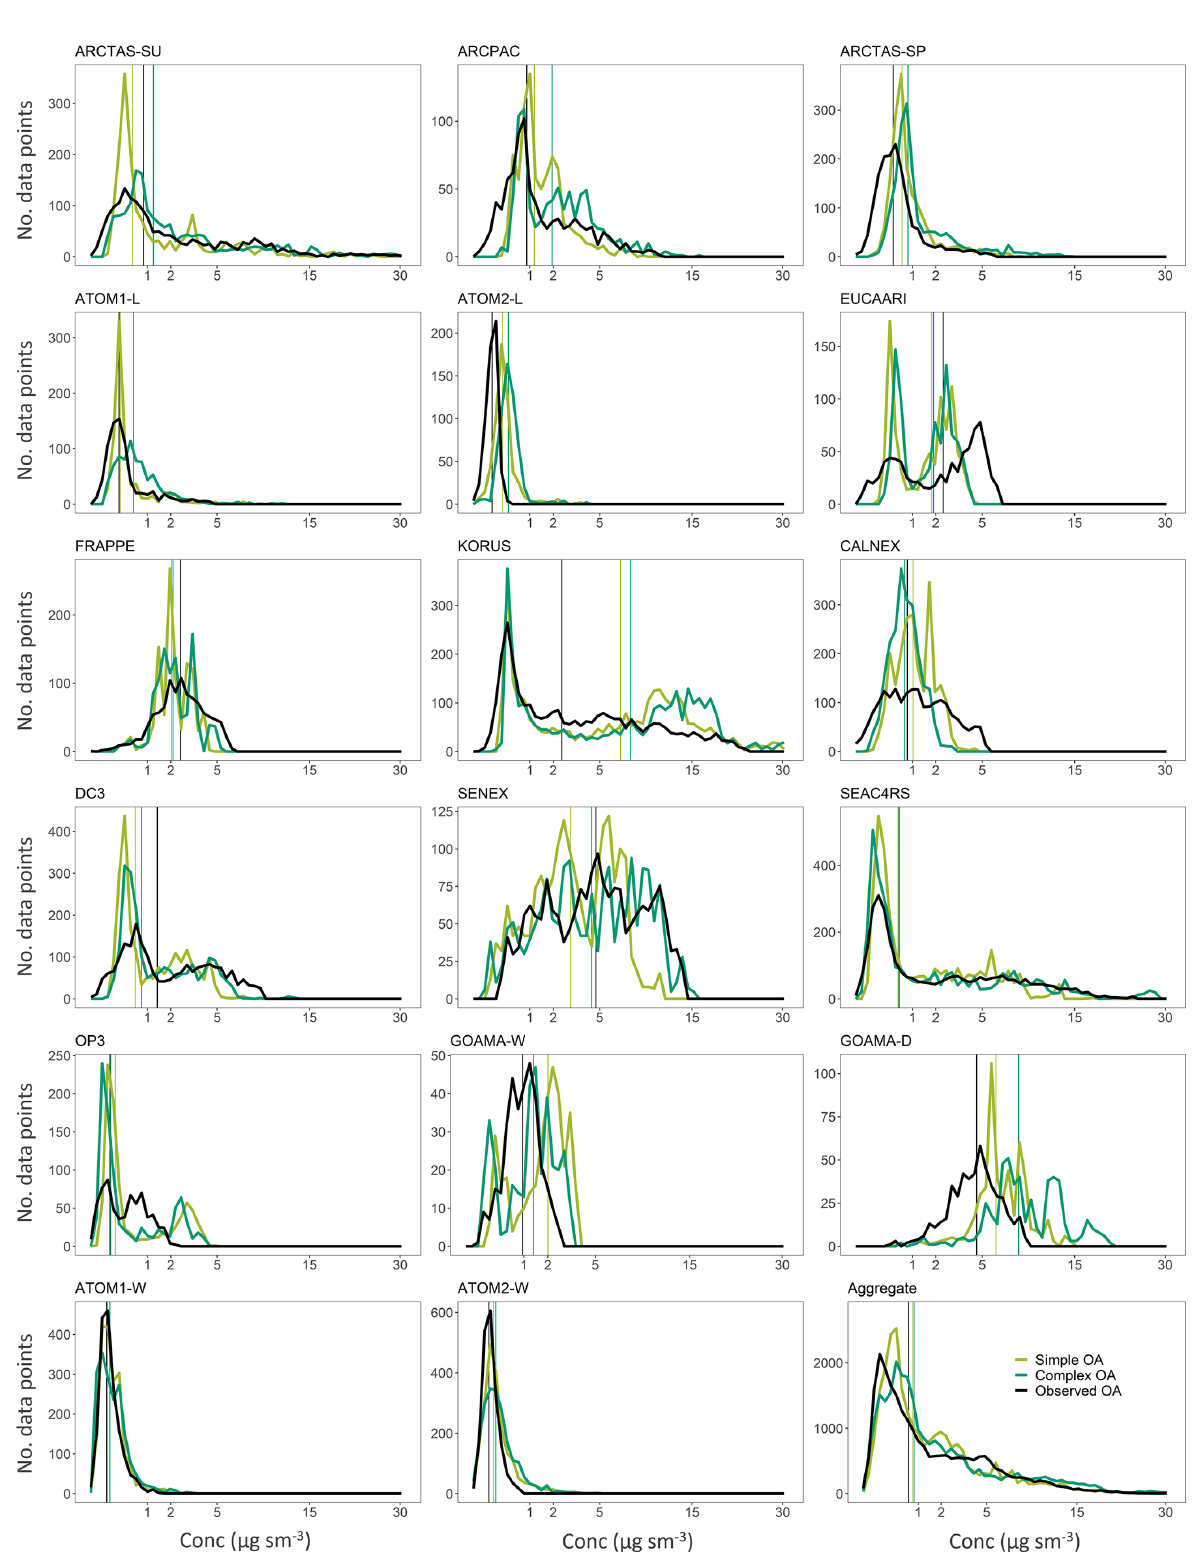
Figure 7. Superimposed distributions from the complex (dark green) and simple (light green) schemes with the observations in black for the different campaigns. Vertical lines represent median values for the different